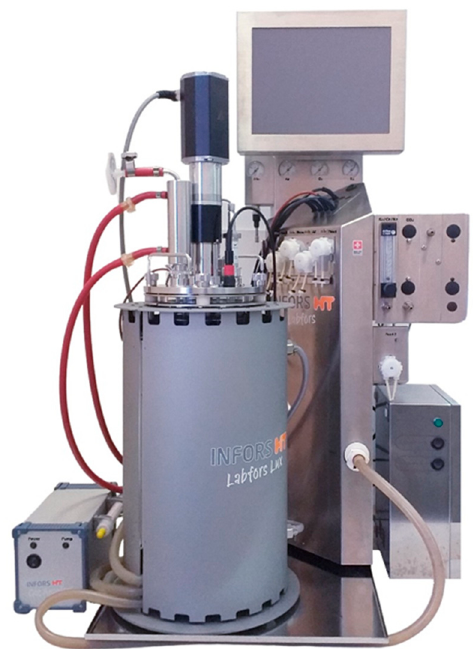
Figure 6. The Labfors 4 Lux photobioreactor (Infors HT, Switzerland) used in this study.